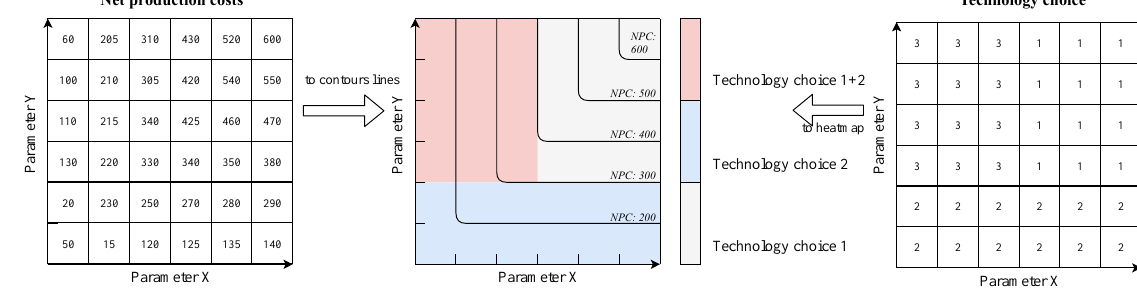
Figure 12. Example building of output diagram of scanning algorithm.